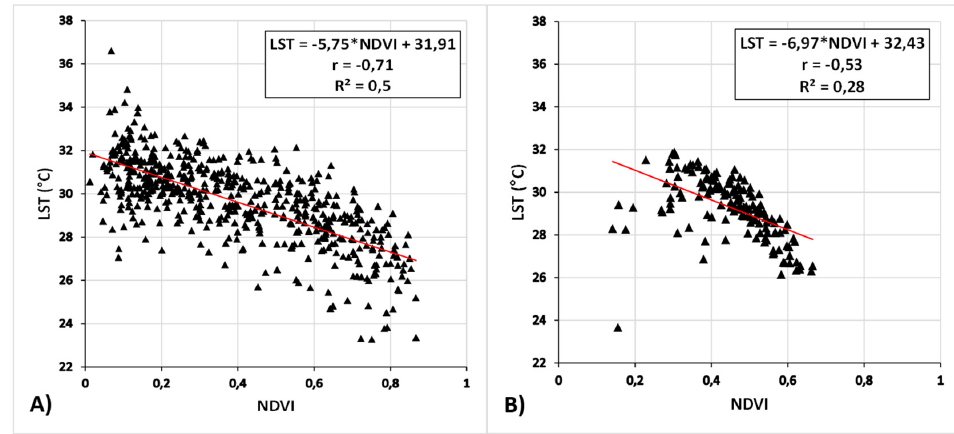
Figure 10. Scatter plots showing: NDVI and LST values in areas with city operated cooling centres ( A ); mean NDVI and LST values for all neighbourhoods ( B ) .